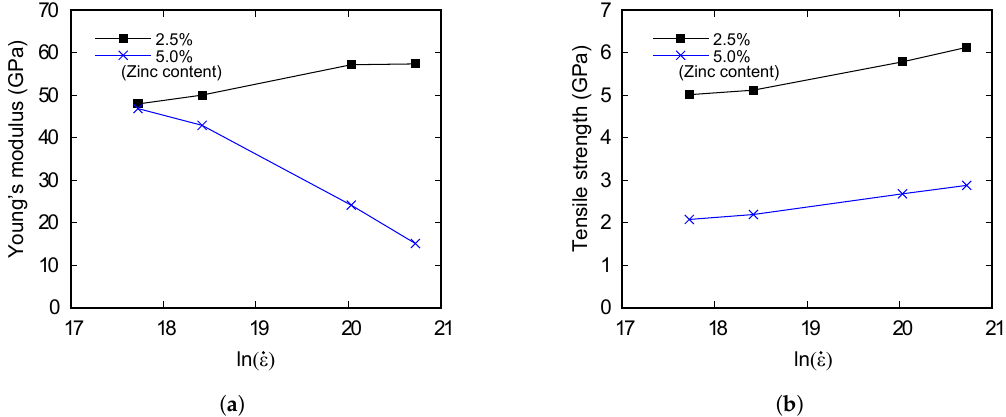
Figure 4. ( a ) Young’s modulus and ( b ) the tensile strength of the models in accordance with strain